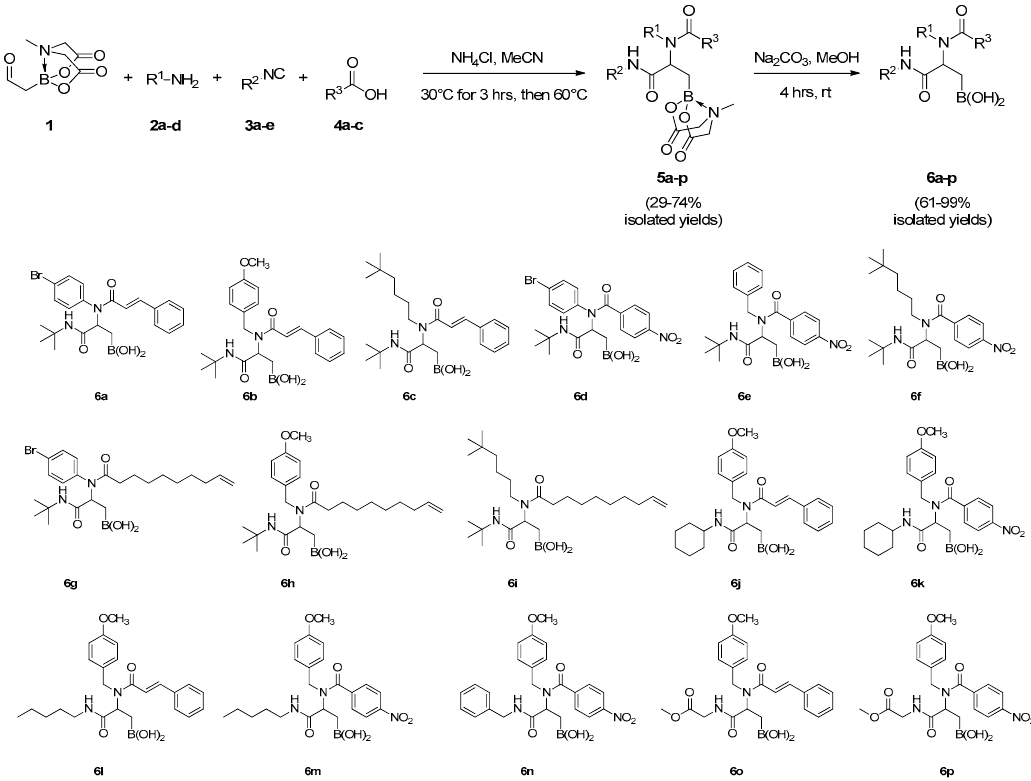
Scheme 2. Scope of the Ugi-4CR aa synthesis of compounds 5a – p : all reactions were performed using